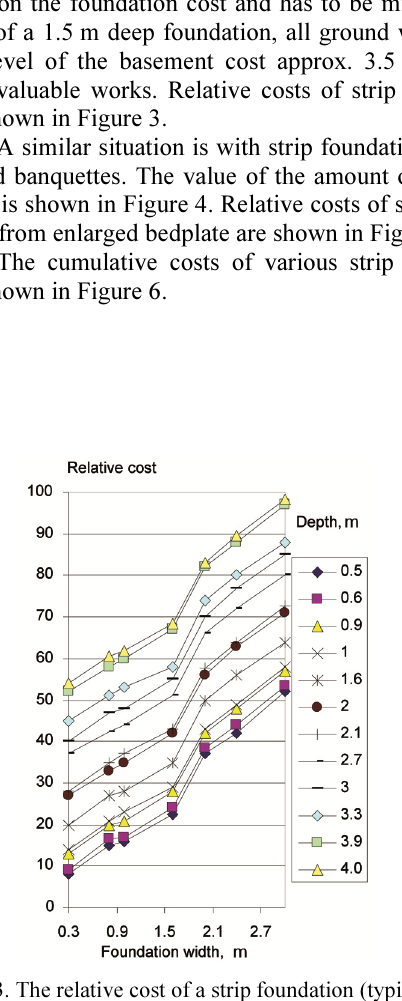
Fig. 2. The cost of ground works for a strip foundation (typical assembled)